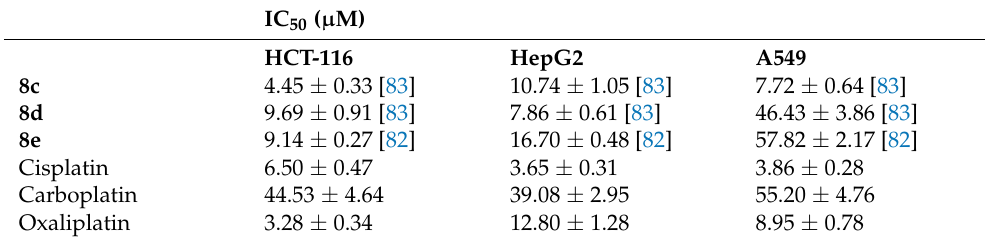
Table 2. IC 50 of different platinum containing bicycles [82,83].